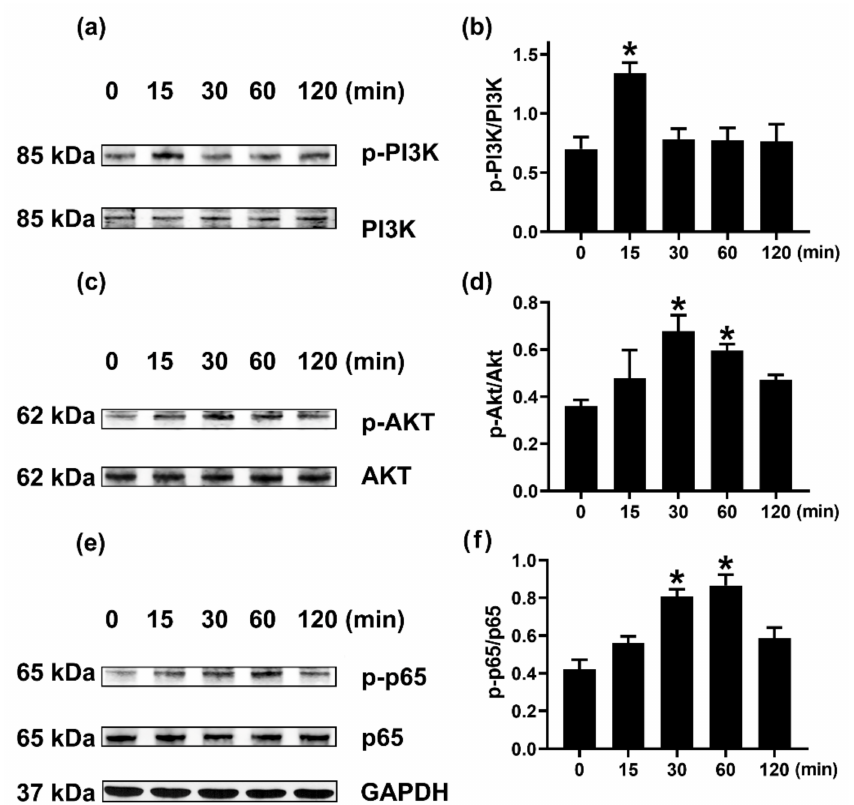
Figure 3. Phosphorylations of PI3K, Akt, and NF- κ B in neutrophil-like dHL-60 cells. ( a , c , e ) dHL- 60 cells (5 × 10 6 ) were stimulated with GM-CSF (5 ng/mL). ( b , d , f ) The protein expression levels were quantitated by densitometry. Data are presented as the mean ± S.E.M. of three independent experiments. * p < 0.05 vs. the 0 min group.